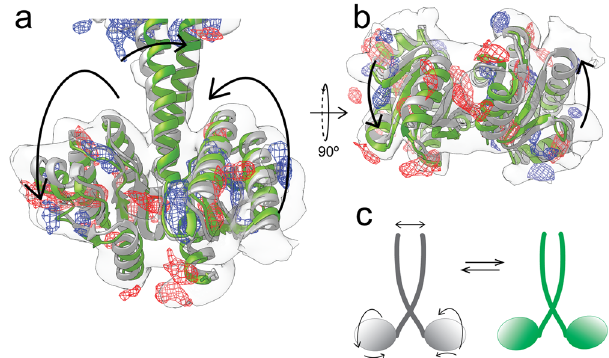
Fig. 5 Conformational changes of the Vv RsbR dimer protomers within the Vv RsbR: Vv RsbS stressosome. Side ( a ) and bottom ( b ) views of a difference map between different off-axis Vv RsbR dimers (blue mesh indicates negative difference density, and red mesh indicates positive difference density). The difference map is superposed on an isolated dimer density shown as transparent surface. The green and white ribbon models indicate two putative conformations of the dimer. The schematic ( c ) indicates the changes in the respective positions of the monomers imposed by the